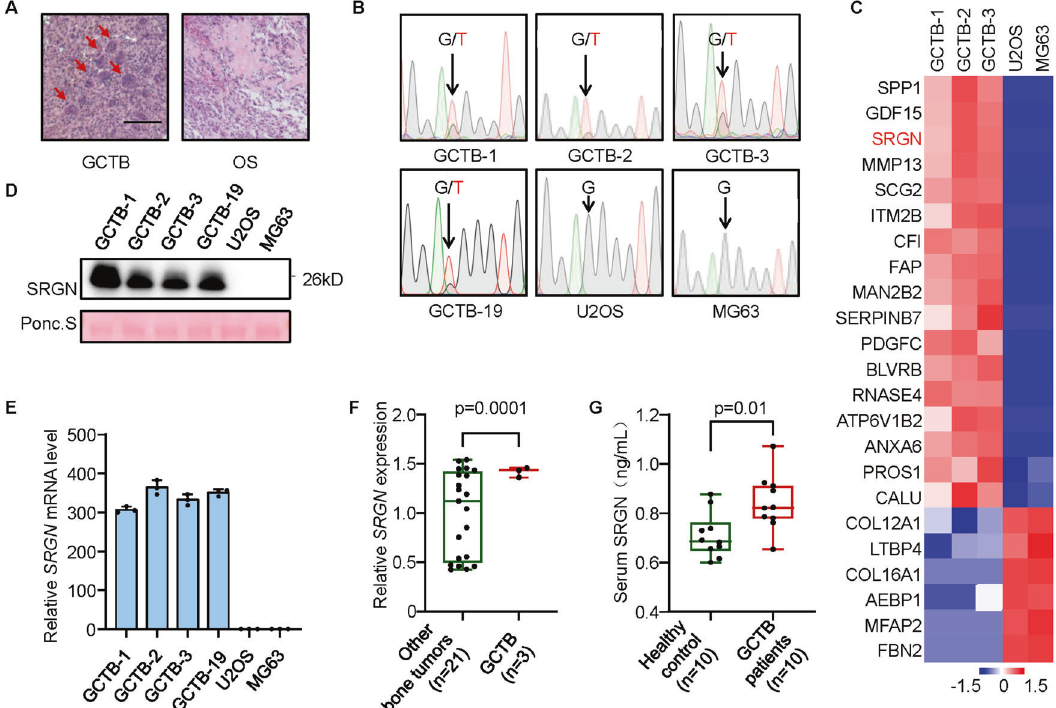
Fig. 1 Expression and secretion of SRGN are upregulated in GCTB. A Hematoxylin and eosin (H&E) staining of GCTB and osteosarcoma (OS) tissues. Arrows point to osteoclast-like MGCs in GCTB. B Genomic sequencing of H3.3 mutations in GCTB primary cell lines (GCTB-1, GCTB-2, GCTB-3 and GCTB-19) and OS cell lines (U2OS and MG63). C Heatmap of mass-spectrum secretomic analysis of GCTB and OS cells. D , E SRGN secretion ( D ) and mRNA levels ( E ) in GCTB and OS cells. F SRGN expression in various bone tumor cell lines in the Cancer Cell Line Encyclopedia database. G Serological SRGN levels of GCTB patients and healthy people. Scale bar, 100 μ m. P values were obtained by two- tailed unpaired t test ( F , G ). Box plots display values of minimum, fi rst quartile, median, third quartile, and maximum. Bar graphs are shown as mean ± s.d. than in osteosarcoma cells (Fig. 1D, E). The expression of SRGN was also signi fi cantly upregulated in GCTB cell lines than in other bone tumor cell lines, including chondrosarcoma, Ewing sarcoma and osteosarcoma, in the Cancer Cell Line Encyclopedia database [35] (Fig. 1F). SRGN was also mildly expressed in bone-metastatic breast cancer cell lines SCP2 and 1833 [36], but not in normal bone stroma cells including mesenchymal stem cells, osteoblasts and osteoclasts (Supplementary Fig. S1E). Upregulation of SRGN in GCTB was likely independent of H3.3 G34W mutation, as its high expression in a GCTB tumor without H3.3 G34W mutation, GCTB-4, was also observed (Supplementary Fig. S1F). We further analyzed the serum samples of GCTB patients and found that the serological SRGN levels were signi fi cantly higher in GCTB patients than in healthy people (Fig. 1G), further con fi rming the enhanced secretion of SRGN by GCTB cells. SRGN promotes osteoclastic differentiation in vitro To study the function of SRGN in GCTB, we knocked down SRGN in a GCTB primary cell line GCTB-1 (Supplementary Fig. S2A). The conditioned medium from GCTB-1 was used to induce osteoclastic differentiation of mouse primary bone marrow cells and the RAW264.7 monocyte cells. SRGN knockdown inhibited the secretion of SRGN into conditioned medium (Fig. 2A) and signi fi cantly decreased the number of mature osteoclasts differentiated from bone marrow and RAW264.7 when cultured in GCTB-1 medium (Fig. 2B, C). Similar effects were observed when SRGN was knocked down in another GCTB stromal cell line GCTB- 19 (Supplementary Fig. S2B and Fig. 2A, D, E). Since the neoplastic stromal cells of GCTB were originated from osteoblast-like mesenchymal precursors, we tested whether SRGN overexpression in the human osteoblast precursor cell line hFOB1.19 was Cell Death and Disease (2021)